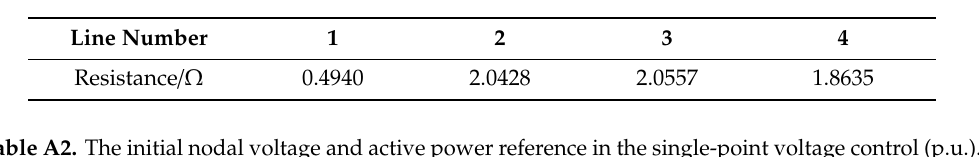
Table A1. The monopolar line resistance of the 4-terminal VSC-MTDC system.